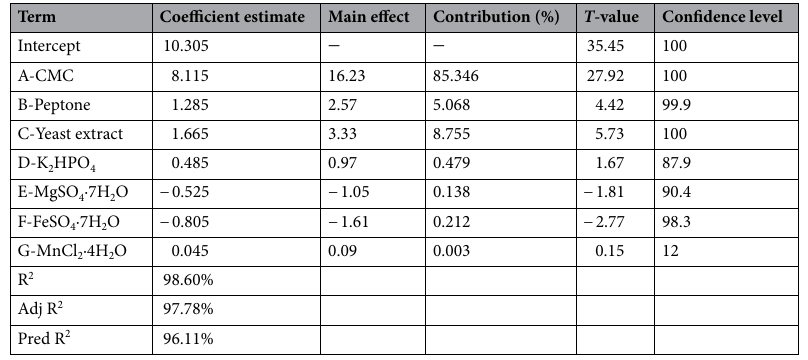
Table 2. Plackett–Burman design regression analysis with the main effect, contribution (%), coefficients estimate, T -value and confidence level for the model and the seven independent variables.